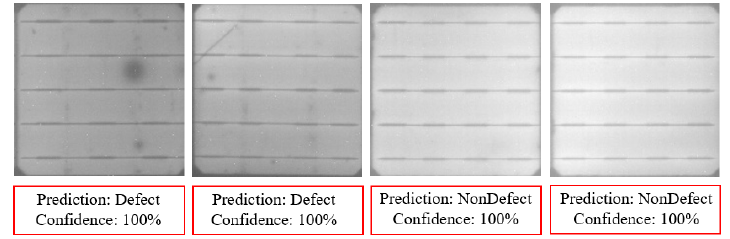
Figure 15. Results of cell image classification.